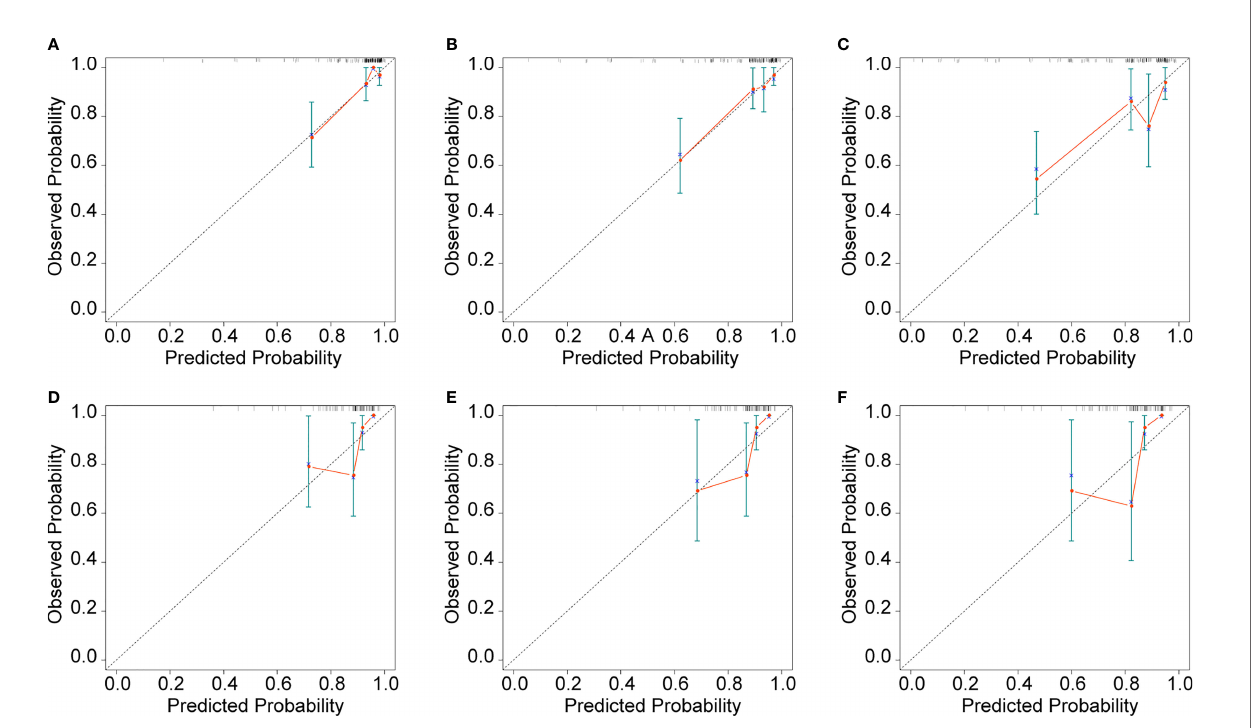
FIGURE 6 | Calibration curves of the training dataset (A – C) and the validation dataset (D – F) in 24, 36, and 60 months.